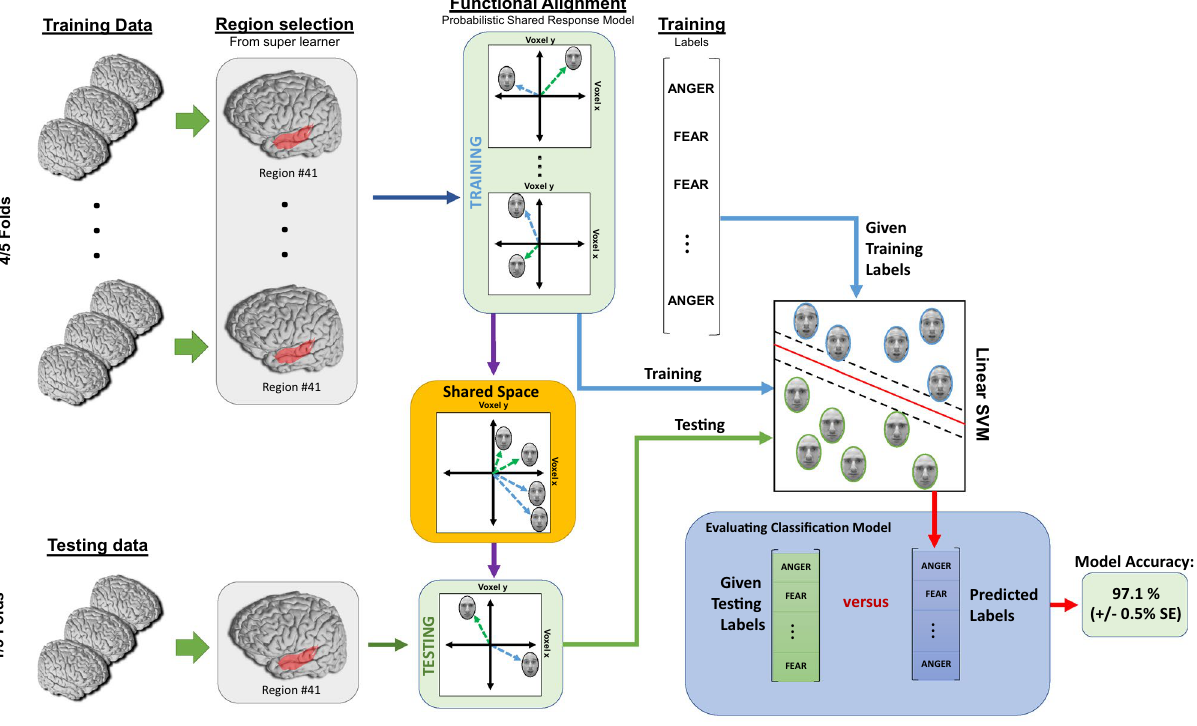
Figure 6. Posthoc analysis: Preprocessing pipeline for negative stimuli analysis. Voxels from the selected region (from the primary analysis) were used to predict the stimulus label for each time point (fear versus anger). We used a probabilistic shared response model (SRM) to transform all functional images into a shared common space. Thereafter, a linear SVM was trained on the functionally aligned data, which were used to predict a facial stimulus for each time point, for each subject. Model metrics include mean accuracy and standard error from fivefold CV.